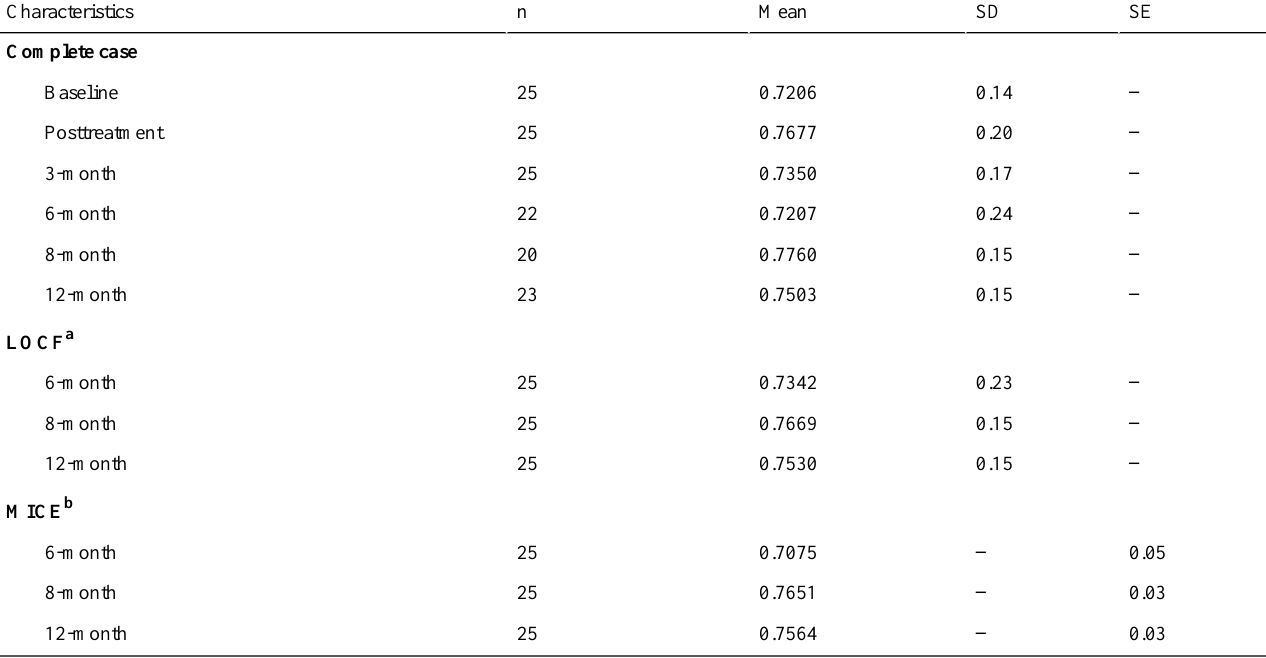
Table 4. EuroQol 5-Dimension 5-Level index each end